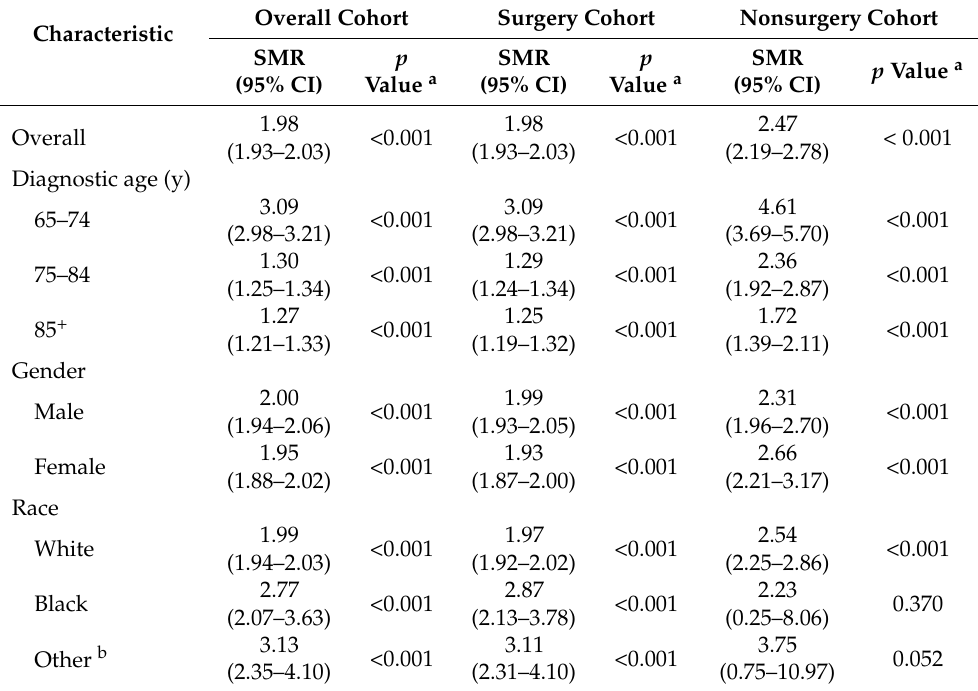
Table 3. Cardiovascular-disease-death-related standardized mortality ratios in malignant melanoma